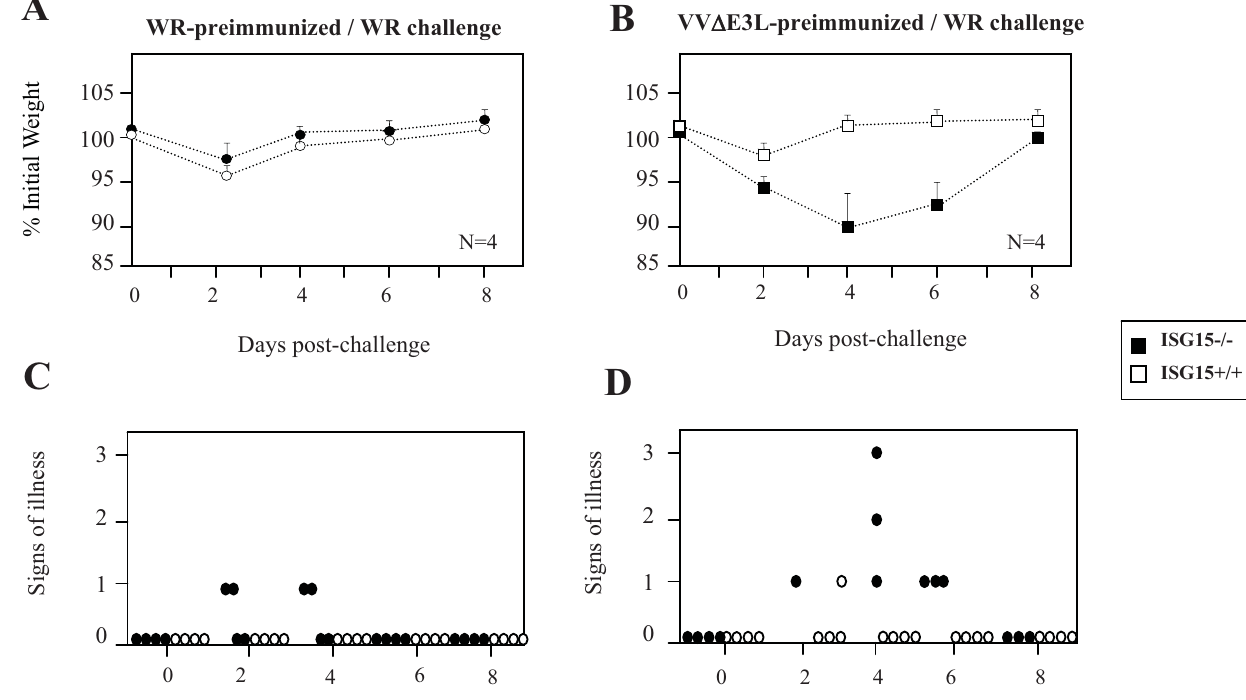
Figure 7. Evaluation of extent of protection of WR or VV D E3L pre-immunized ISG15 + / + and ISG15 2 / 2 mice after challenge with WR. Four mice per group were first i.p, immunized with purified WR (2 6 10 7 PFU/mouse) or VV D E3L (10 8 PFU/mouse), and 30 days later animals were i.n. challenged with 2 6 10 7 PFU/mouse of purified WR. A–B . Mice were individually weighed daily, and mean percentage weight loss of each group (n=4) was compared with the weight of mice taken prior to the booster. C–D . For each mouse signs of illness, such as ruffled fur and lack of activity, were monitored with the time and are given in arbitrary units.